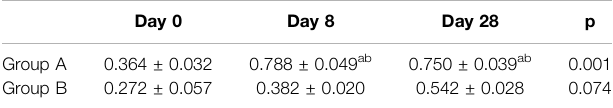
( Figure 1A ). Visual reevaluation with laser doppler perfusion imaging at the 28th day revealed restoration of perfusion in the ischemic hind limb of Group A (microRNA-126-treated group) while there was signi fi cant perfusion defect in the ischemic hind limb of Group B (control group)